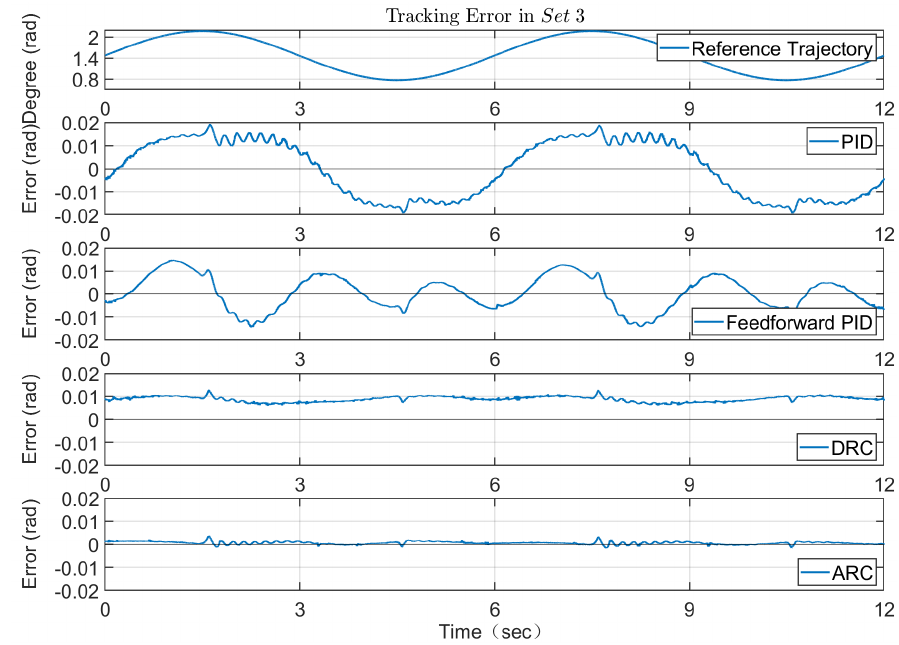
Figure 6. Sinusoidal trajectory tracking error comparison diagram with Posture A.